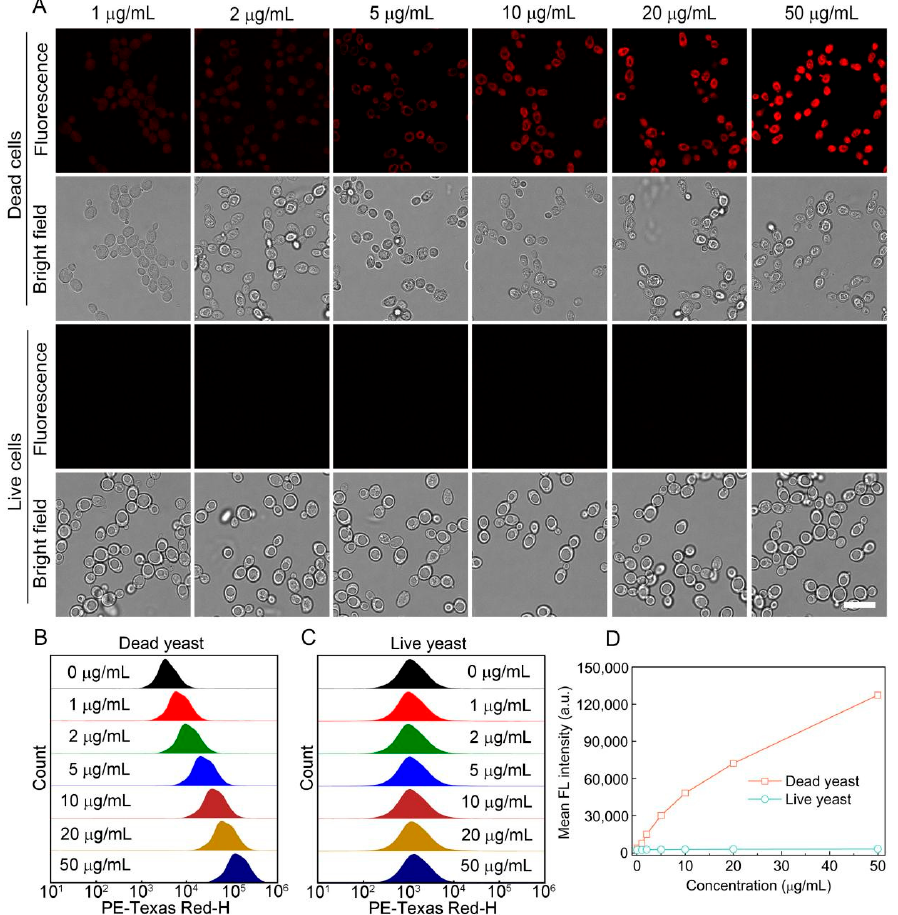
Figure 5. ( A ) Confocal images of dead and live S . cerevisiae cells incubated with various concentrations of S-OSiNDs for 30 s. Scale bar = 10 µ m. Flow cytometric results of the dead ( B ) and live ( C ) S . cerevisiae cells incubated with different concentrations of S-OSiNDs for 30 s and ( D ) corresponding quantitative mean fluorescence intensities derived from the flow cytometric